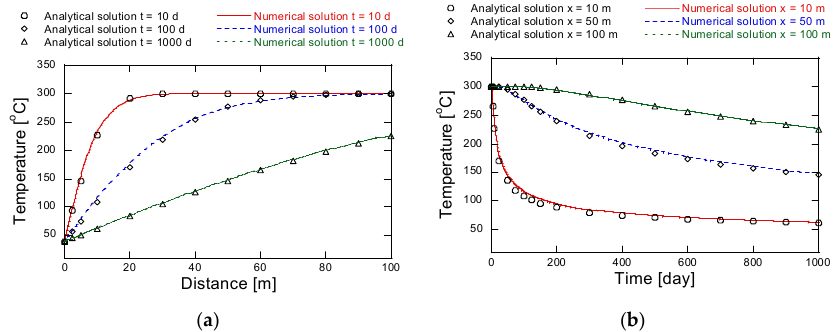
Figure 8. Temperature distribution: ( a ) in discrete fracture at different times; ( b ) in discrete fracture at different distances from the injection well. Table 1. Material parameters in the 2D single-fracture model.